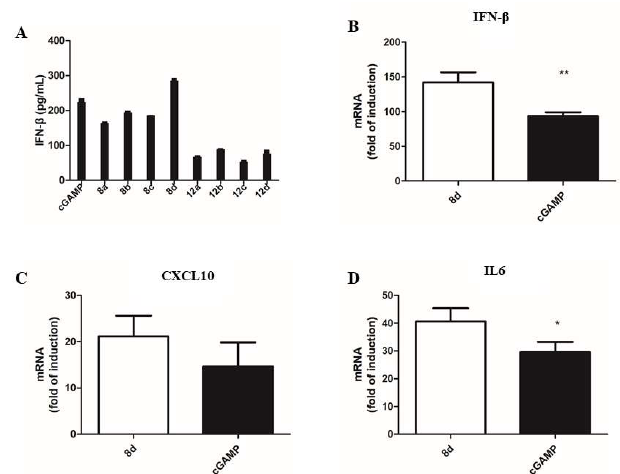
Figure 3. Cytokine induction in THP-1 cells. ( A ) THP-1 cells collected at 18h after cGAMP analogs (1 µ M) administration were used to detect the production of IFN- β by enzyme-linked immunosorbent assay (ELISA). Expression analysis of IFN- β ( B ), CXCL10 ( C ) and IL6 ( D ) in THP-1 cells after the treatment of 8d and cGAMP (5 µ M) with 12 h was detected by RT-qPCR expressed as a fold induction. Data represent means ± SEM; ** p < 0.01 and * p <